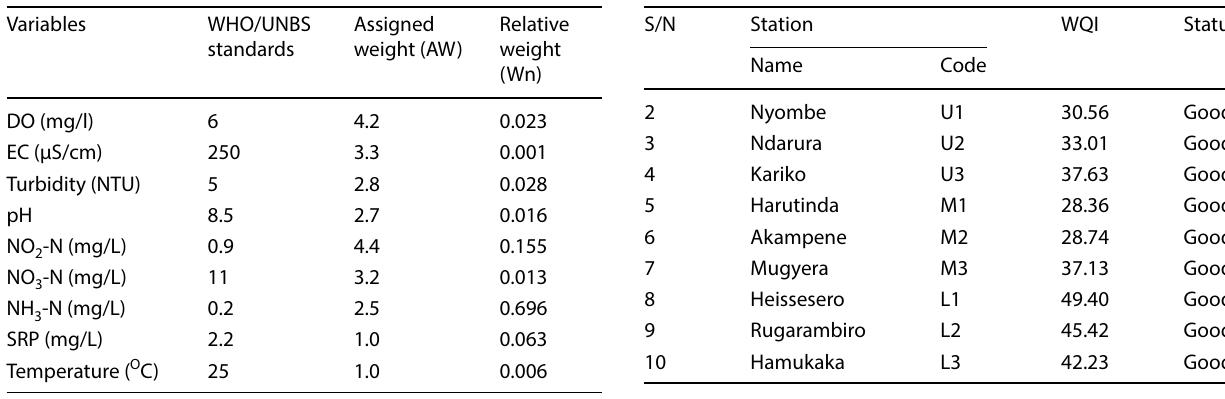
Table 9 Change in the WQI values across the study